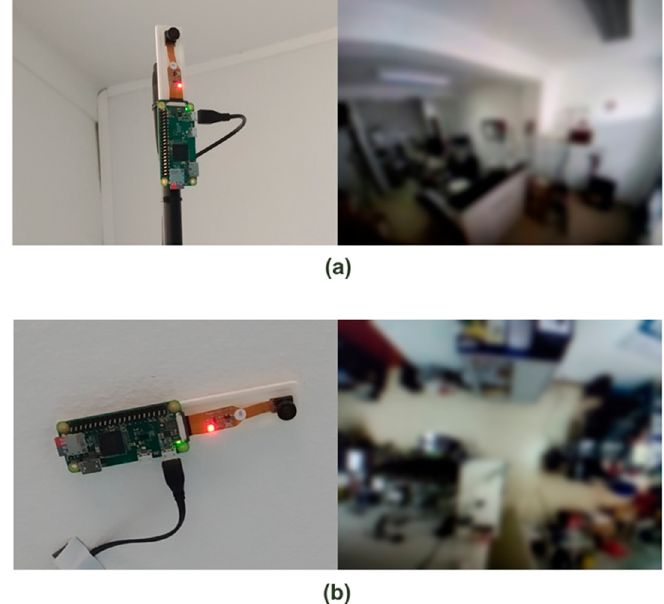
Figure 4. Raspberry PI Zero W #1 ( a ) and #2 ( b ).